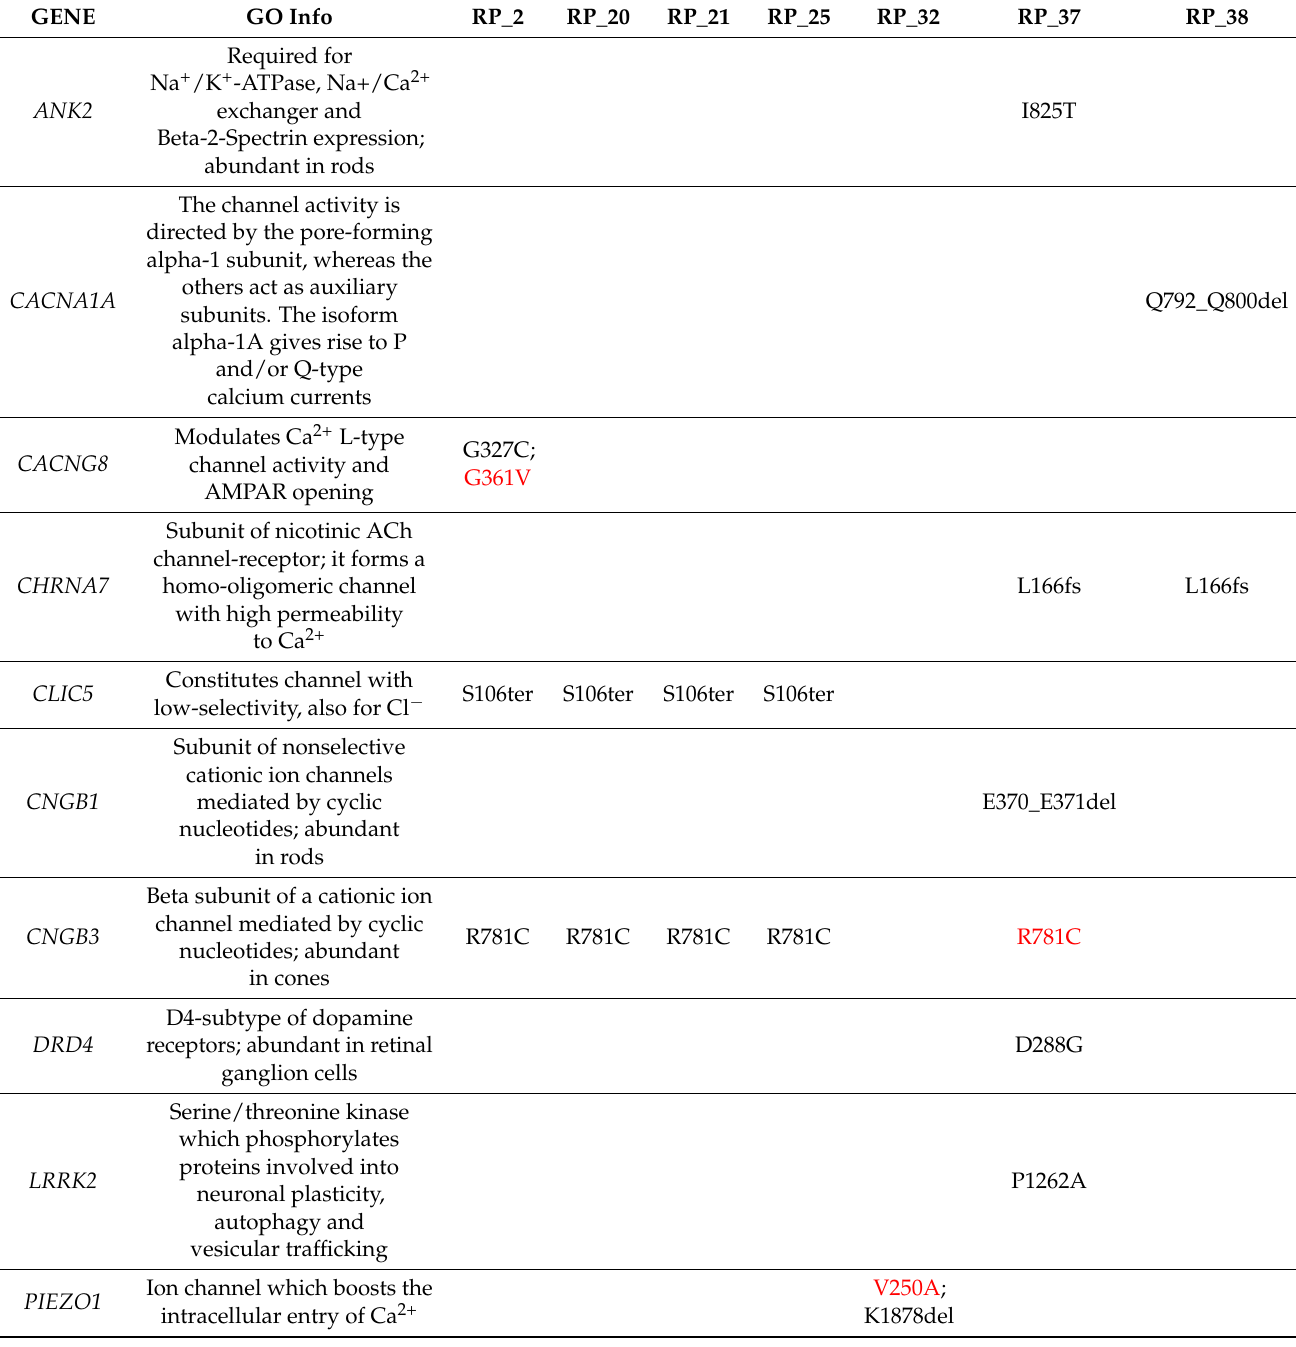
Table 3. Mutated genes related to ion channels were identified in the probands of the analyzed families. The GO annotation of family probands’ WES detected several variants carried by genes related to ion channel activity screened family probands. The homozygous variants are highlighted in red